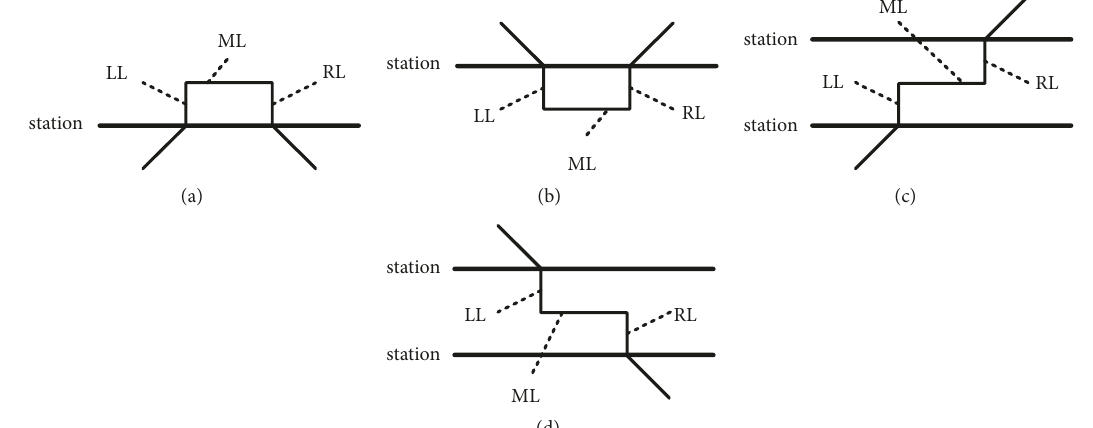
Figure 2: The diagrams of the connection line.